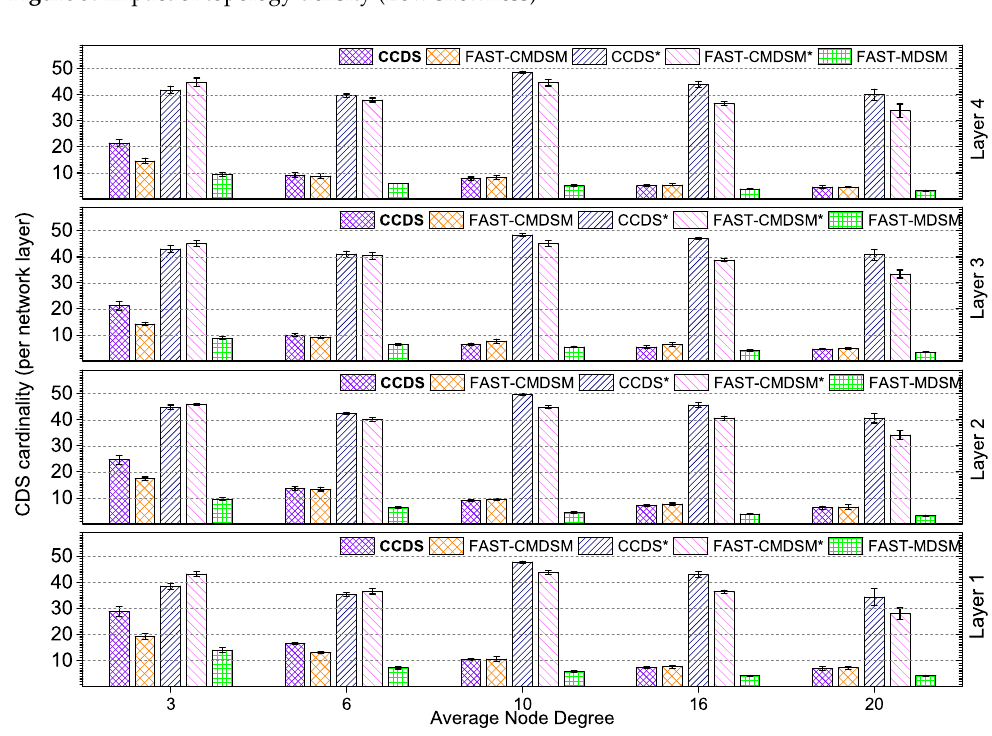
Figure 4. Impact of topology density (High